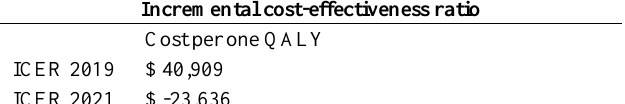
Figure 2 : The difference in the utility (QoL) between the two groups before and ≥12 weeks after infliximab treatment